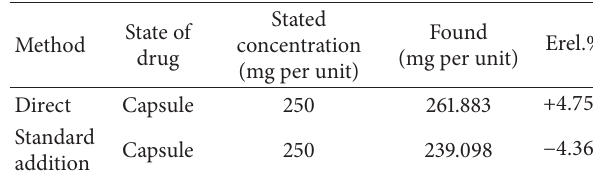
Table 6: Relative error percentage for determination of TC-Au complex by direct and standard addition FAAS